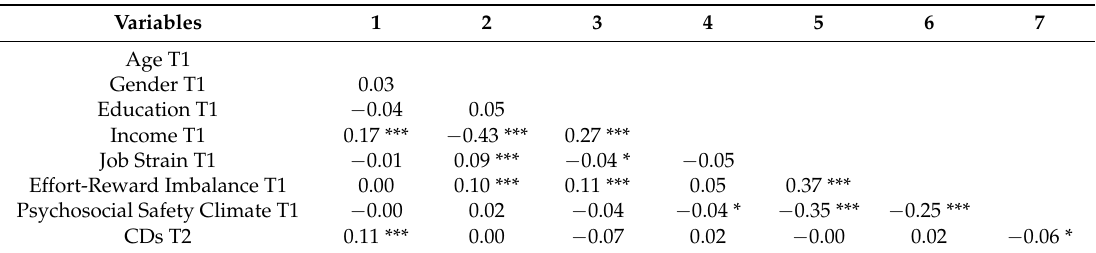
Table 1. Intercorrelations between study variables.